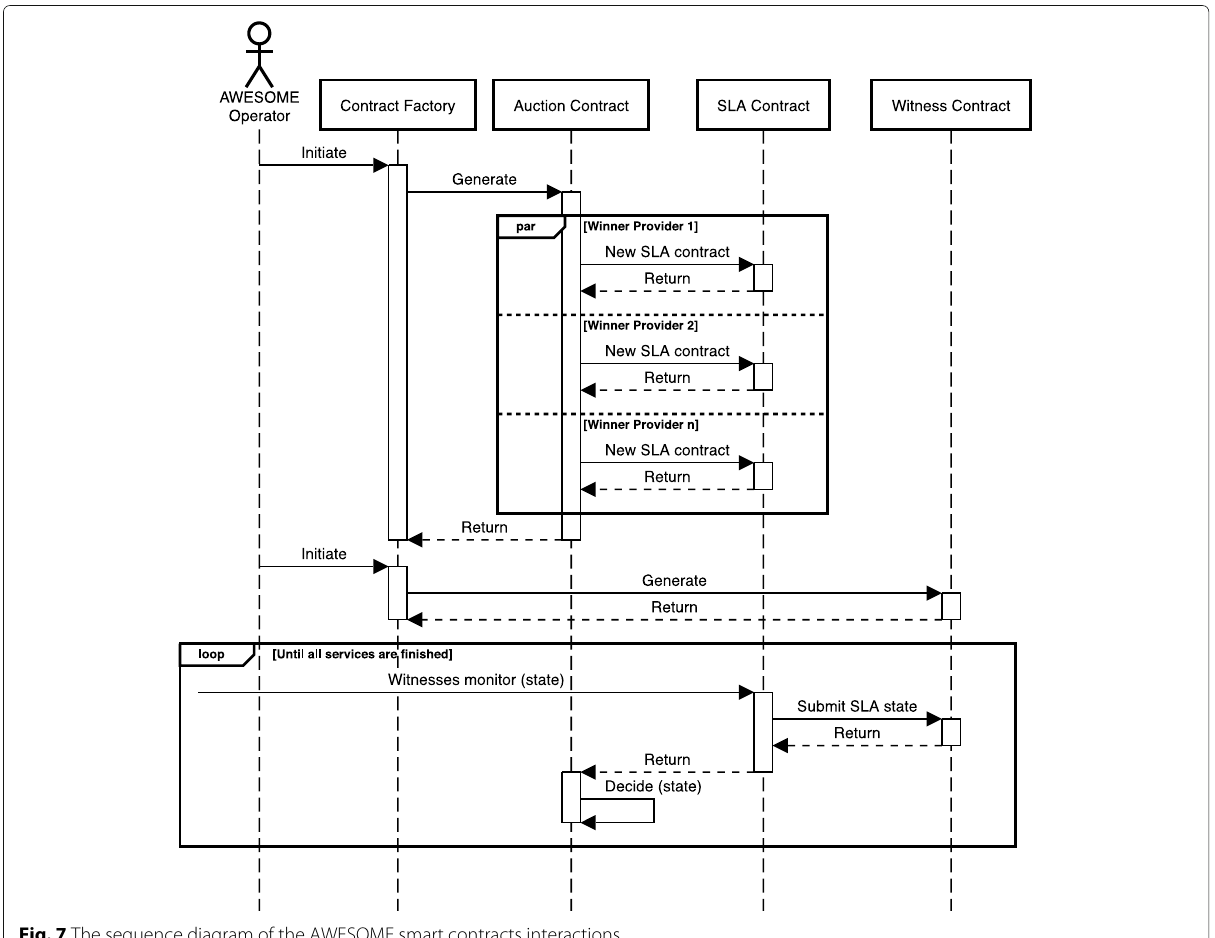
Fig. 7 The sequence diagram of the AWESOME smart contracts interactions